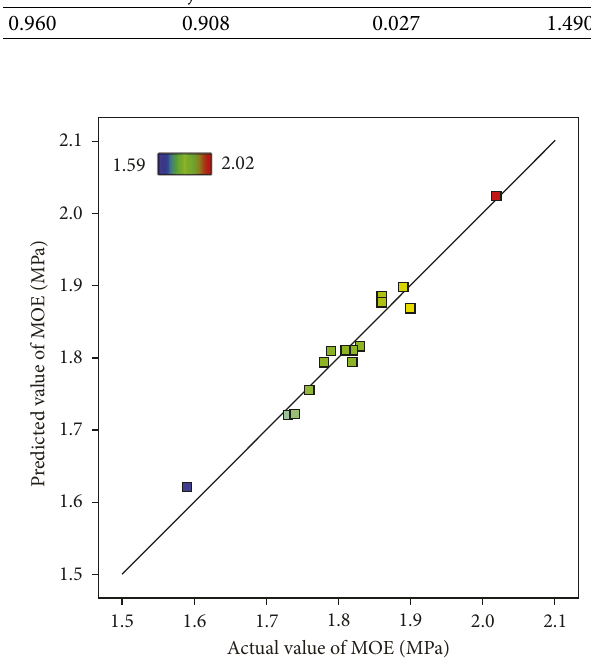
Figure 2: Predicted vs. actual value of MOE.